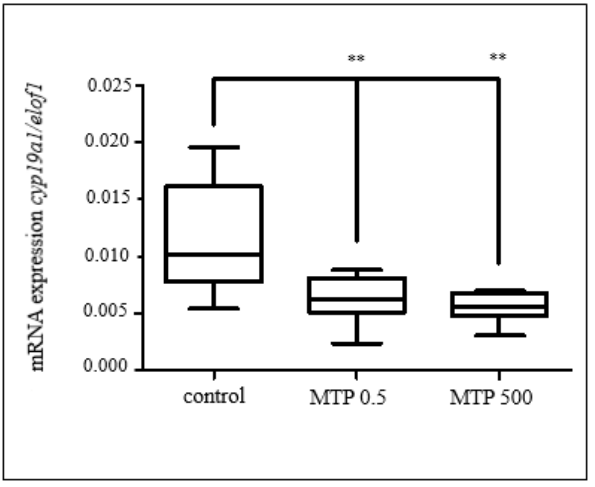
Figure 6. Relative mRNA expression of selected genes in X. laevis embryos exposed to MTP. Concentrations are indicated in µg/L. Box plot graphs were constructed using median, Q1, Q2 with whiskers of maximum 1.5 interquartile range. Statistically significant differences are indicated ** ( p < 0.01).